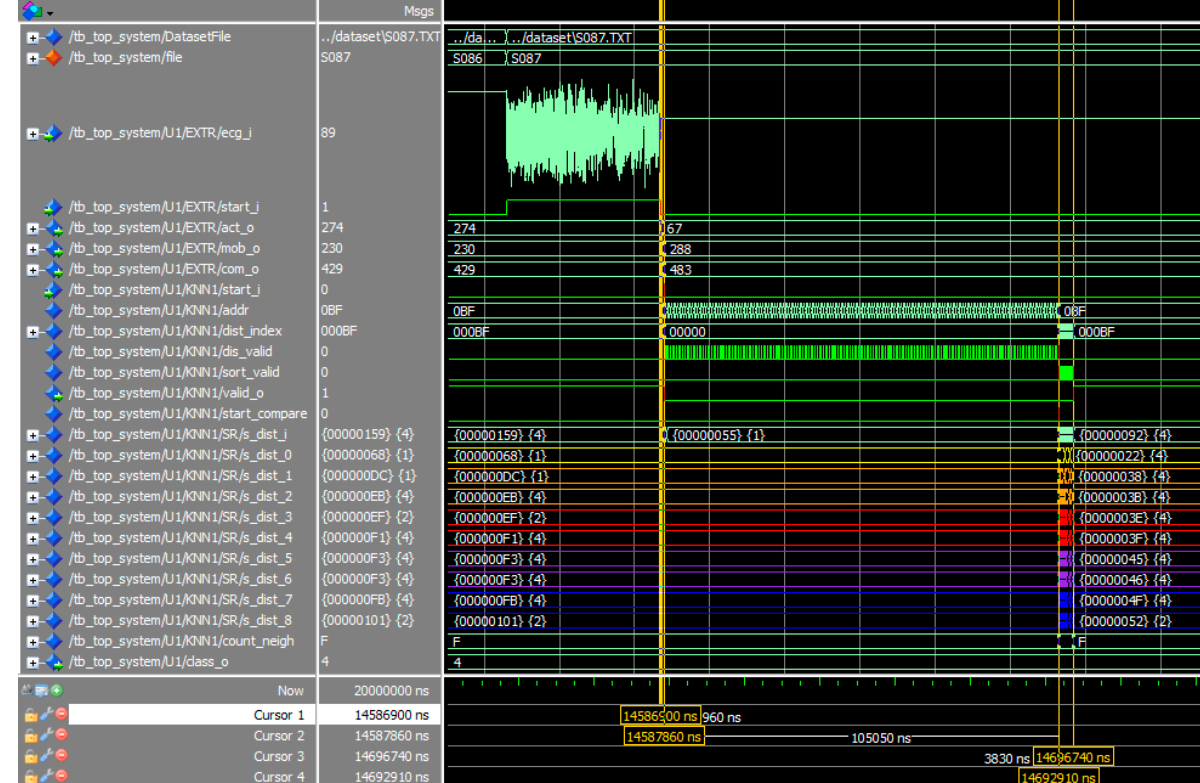
Figure 7. Waveform simulation results for one of the ictal samples; the rainbow waveforms show the closest saved models to the input signal where its values are distance and class (4 = ictal, 2 = normal).